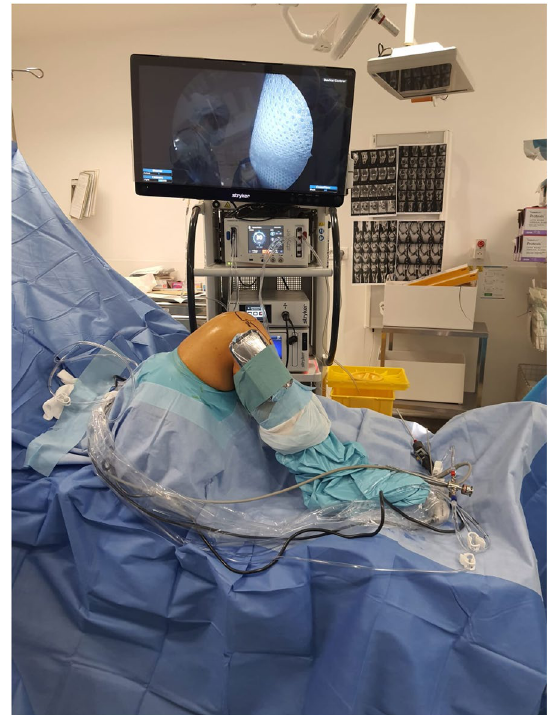
Fig. 1 The smartphone was placed in a sterile bag and sealed airtight to maintain sterility and placed on the Gerdy’s tubercule